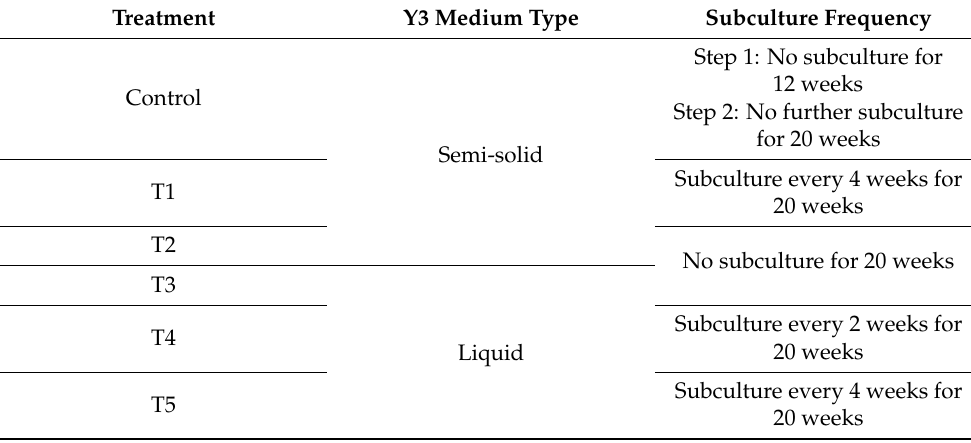
Table 3. Treatments applied to the coconut plumules in Experiment 1, listing the medium type and subculture frequency